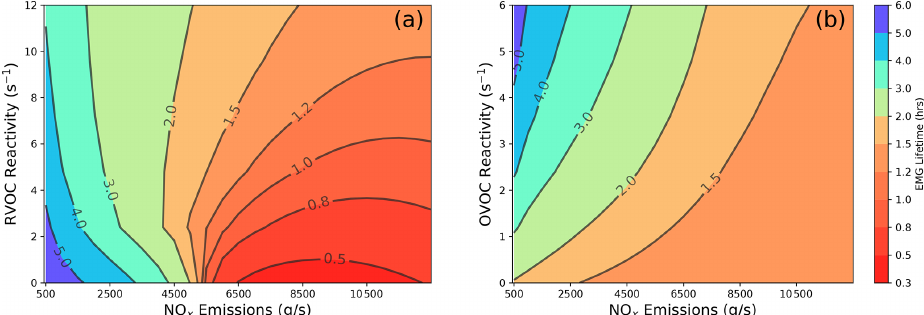
Figure 7. Same as Fig. 6 but showing the NO x lifetime dependence on NO x emissions versus the reactivities of (a) RVOC and (b) OVOC. We run the model at a constant wind speed of 5ms − 1 , and the P (HO x ) is set constant at 50 × 10 6 molec.cm − 3